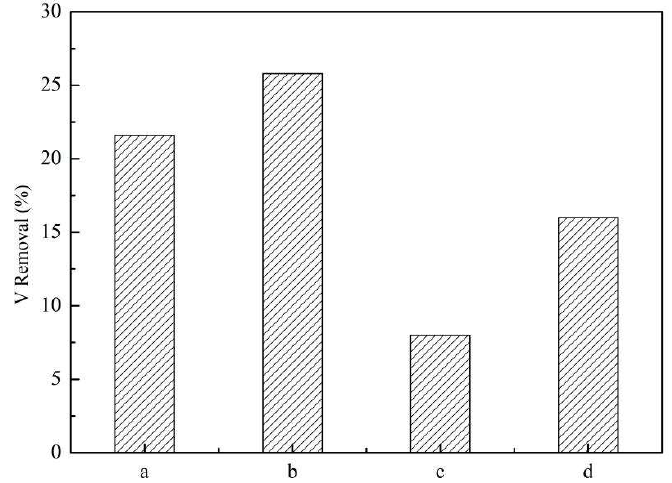
Figure 4. Removal of vanadate by (a) Mg-Fe-Ti-LDHs-Cl-1, (b)Mg-Fe-Ti-LDHs-Cl-2, (c) Mg-Fe- Ti-LDHs-CO 32 − and (d) Mg-Fe-Ti-CLDH (experimental conditions: C 0 = 50 mg/L, adsorbent dosage = 10 mg, pH = 5.0, contact time = 24 h, T = 298 K).